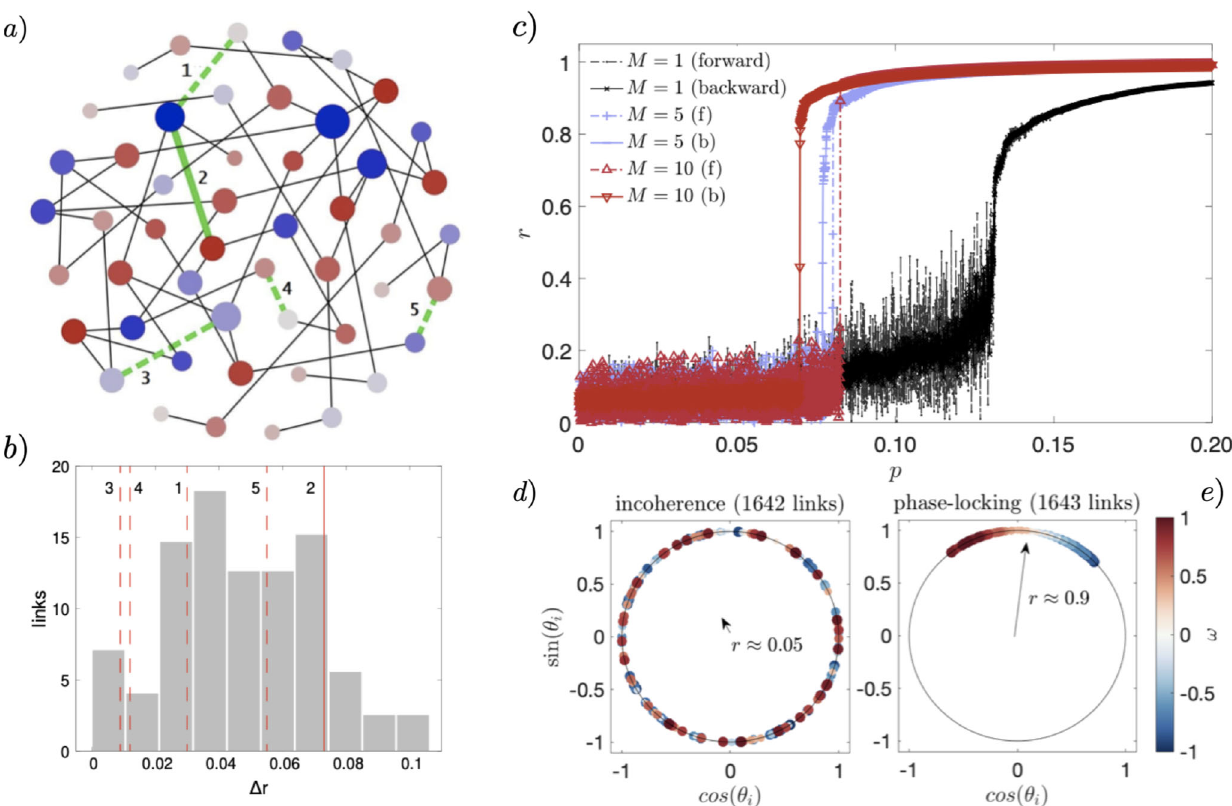
Fig. 1 Basic phenomenology in the Kuramoto bomb. a Illustrative network of N = 50 oscillators where the size of the node is proportional to its degree, the color is related to its natural frequency (blue for ω = − 1, gray for ω = 0 and red for ω = 1) and the black lines represent the links between the oscillators. Green lines mark the M = 5 potential links sampled in that p -step. The continuous line represents the chosen link and the dashed ones are the discarded ones. b Histogram of the Δ r values for the existing links of the network, where red lines correspond to the values of the fi ve sampled links. c Example of the typical synchronization transition in our bomb-like model, with the order parameter r depending on the fraction of links, p in a system of N = 200 Kuramoto oscillators for fi xed coupling strength λ = 0.05 and three values of sampling M . Equation (1) is numerically integrated using Heun ’ s method, with dt = 0.05, 10 4 time steps and temporal averages of r are taken at each link change. In d , we represent the oscillators phases for the M = 10 case before and in e after the forward transition. Note that this jump in the Kuramoto order parameter from incoherence to complete phase-locking takes place just with the addition of one